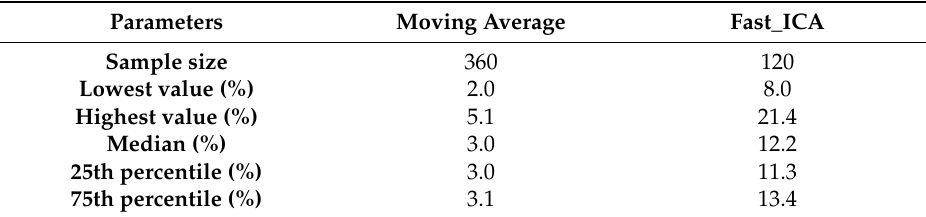
Figure 7. Performance comparison between our method and independent component analysis (ICA). Table 4. CPU usage comparison graph.